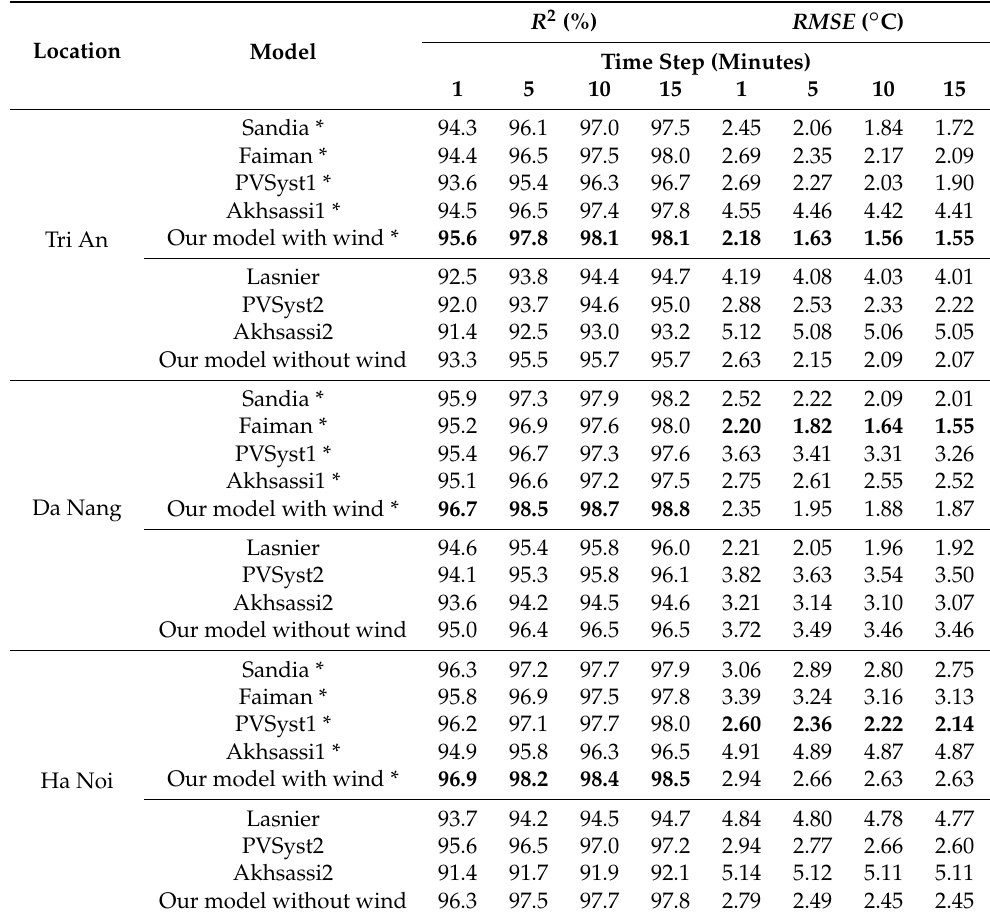
Table A1. Results obtained for predicting module temperature with different time steps and